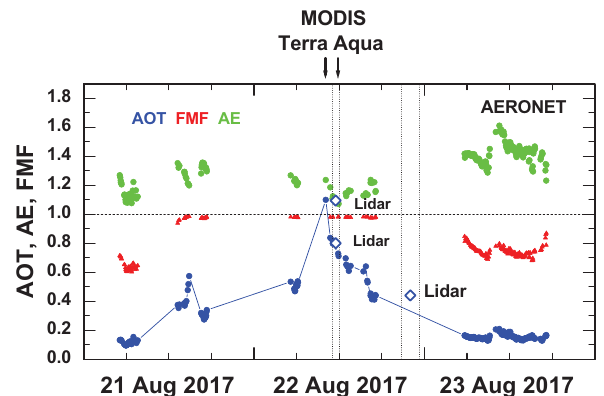
Figure 7. AERONET sun photometer observations at Leipzig (TROPOS) from 21 to 23 August 2017. 500nm AOT (blue circles), Ångström exponents AE (green circles, for the 440–870nm wave- length range), and AOT fine-mode fraction FMF (red triangles, for 500nm AOT) are shown. Gaps in the time series are caused by cloud fields and nighttime hours. Dashed vertical lines indicate the lidar measurement periods around noon and at nighttime (Fig. 6). The lidar-derived 532nm AOT (blue open diamonds) are also given. AOTs are obtained with an input lidar ratio of 50sr (AOT of 0.8 on 22 August around noon) and 70sr (AOT of 1.1 around noon and 0.42 in the night of 22 August). The horizontal line at 1.0 indicates that the FFM values were close to 1.0 during the passage of the smoke layers which meant that the AOT was almost entirely caused by light extinction by fine-mode particles. The overpass times of MODIS Terra and Aqua are indicated above the figure by two ar- rows. MODIS results are shown in Fig.